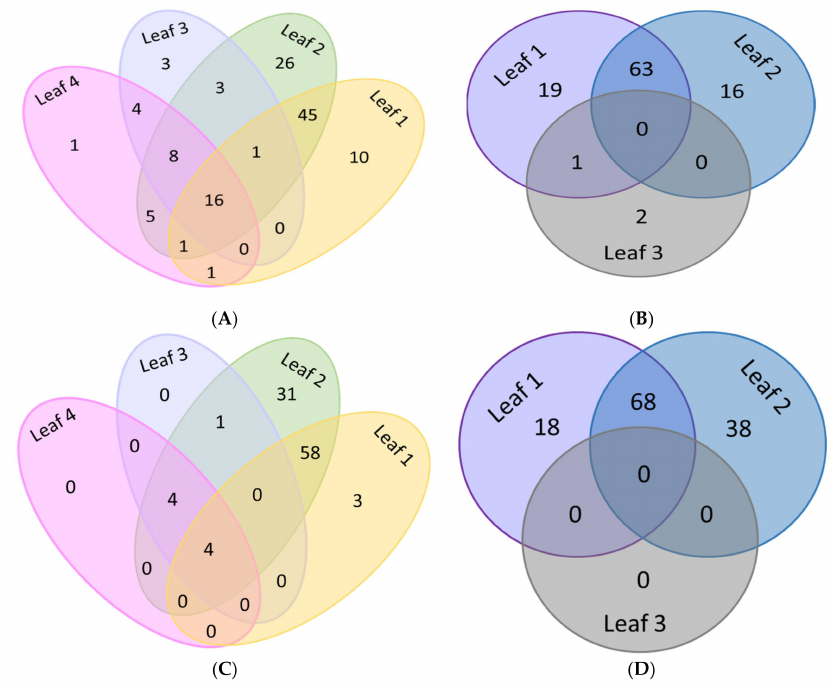
Figure 4. Venn diagram of the numbers of di ff erentially methylated promoters of defence genes between leaves from control plants and leaves from infected plants with Leptosphaeria maculans of B. napus cultivars Westar (susceptible) and Sturt (resistant). Hyper-methylation in Sturt ( A ) and Westar ( B ); Hypo-methylation in Sturt ( C ) and Westar ( D